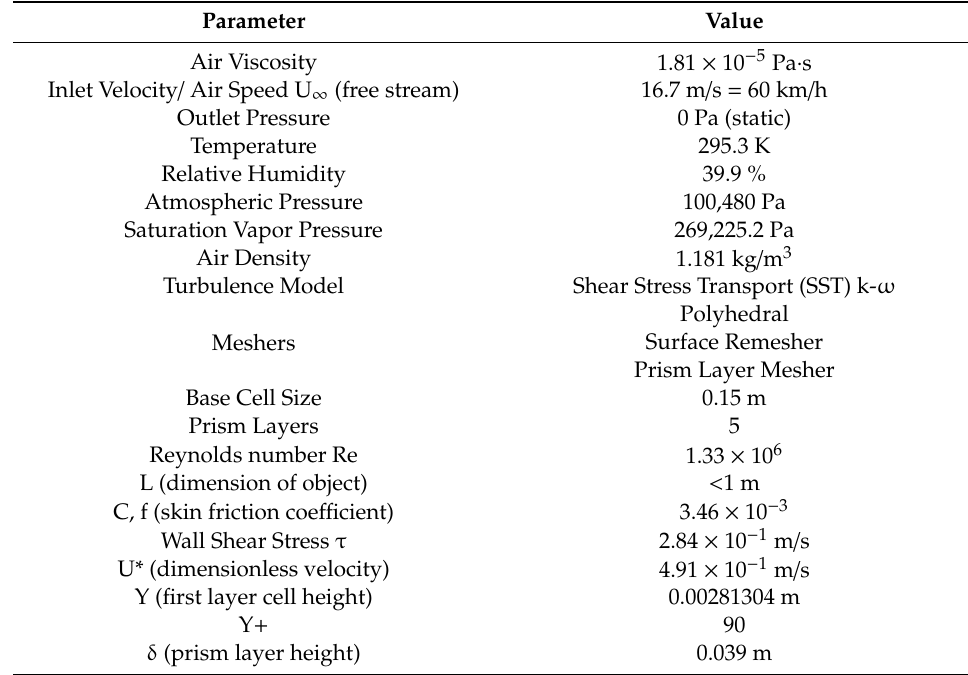
Table 2. List of parameters for computational fluid dynamics (CFD)